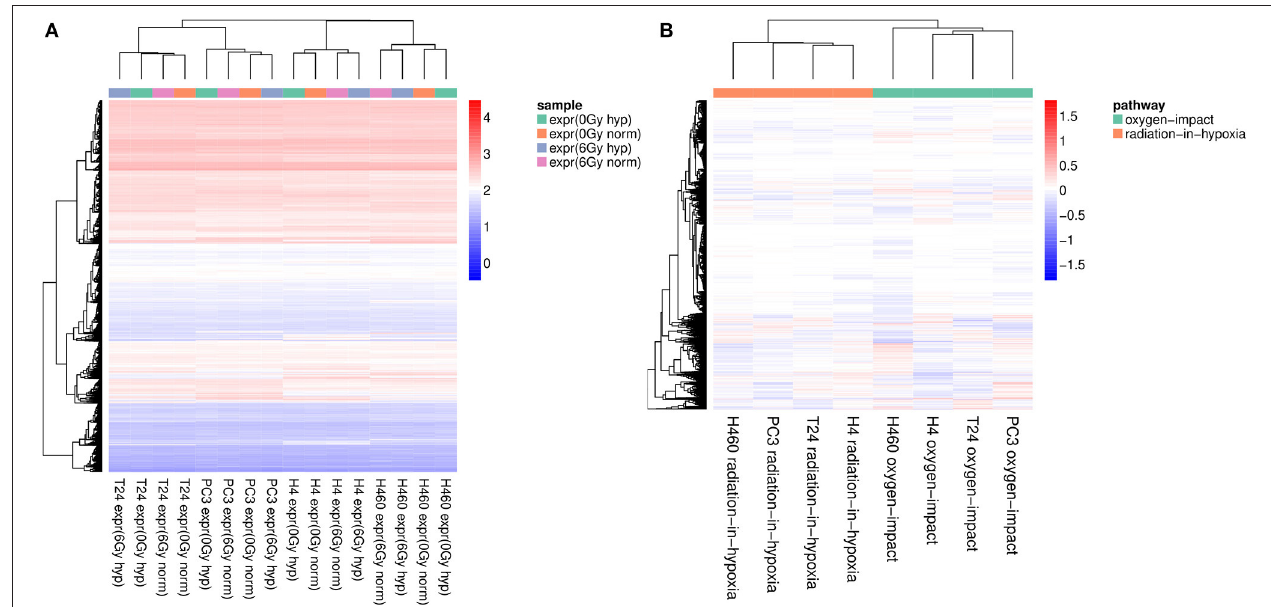
FIGURE 2 | (A) Hierarchical cluster-analysis-heatmap of the expression set composed of 16 expression samples. The samples are clustered based on the cancer tissue they belong to. (B) Hierarchical cluster-analysis-heatmap of the expression profiles. A clear separation between the two profiles across all four cell lines is visible. In addition, the samples recorded for H4 and T24 are the most similar, as they are clustered with a node in the first place. All expression values were log 2 normalized before performing the cluster